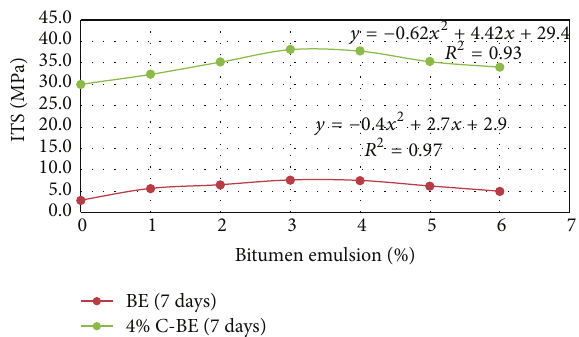
Figure 3: Influence of bitumen emulsion content on MS of BETB and CBETB. Here, “C” denotes cement and “BE” denotes bitumen emulsion.